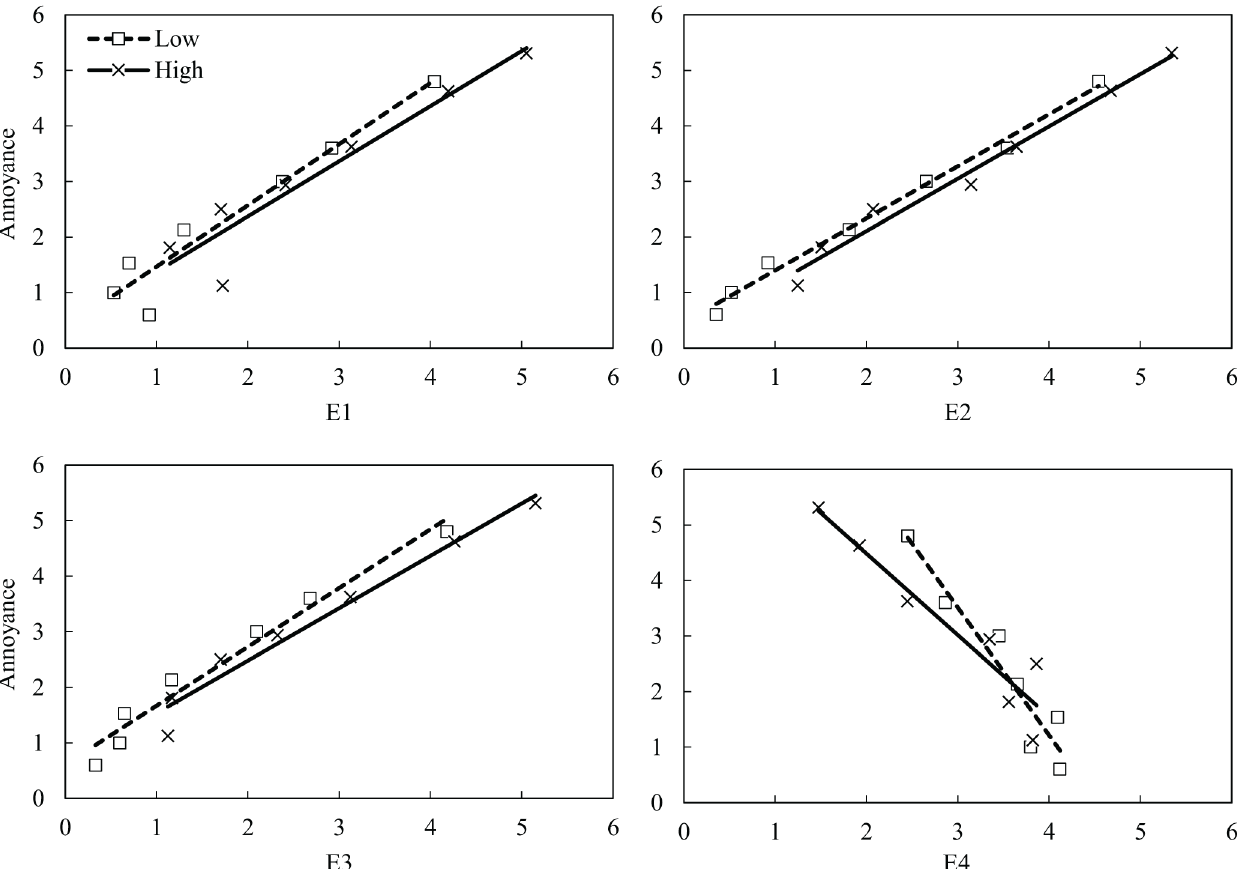
Fig 4. Relationships between noise annoyance and perceived emotions for low ( □ ) and high (×) noise-sensitivity groups.